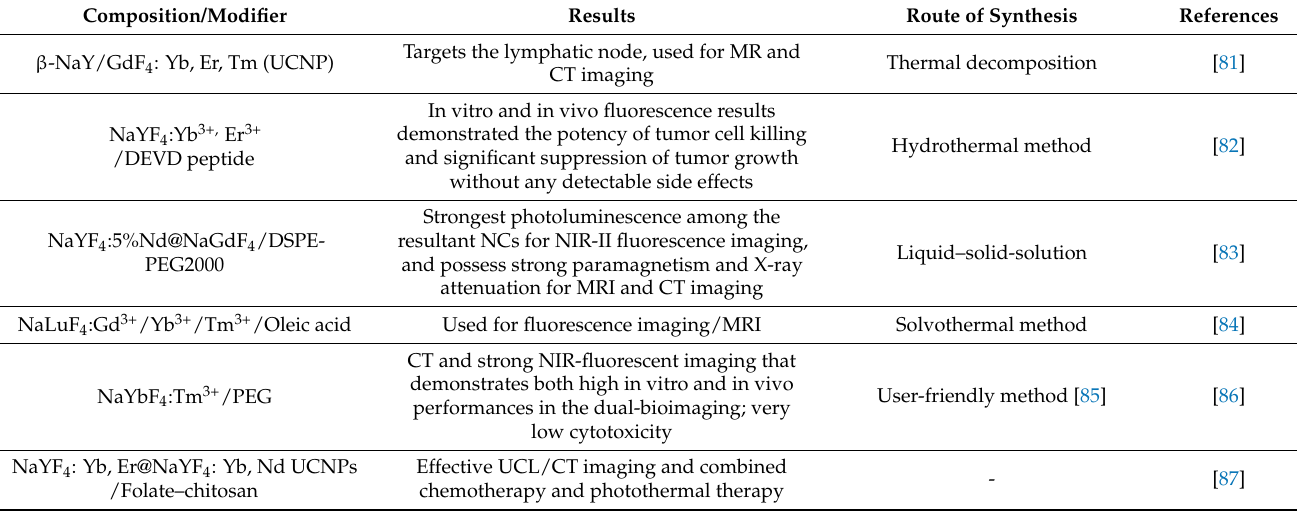
Table 2. Composition and synthesis of UCNPs for bioimaging